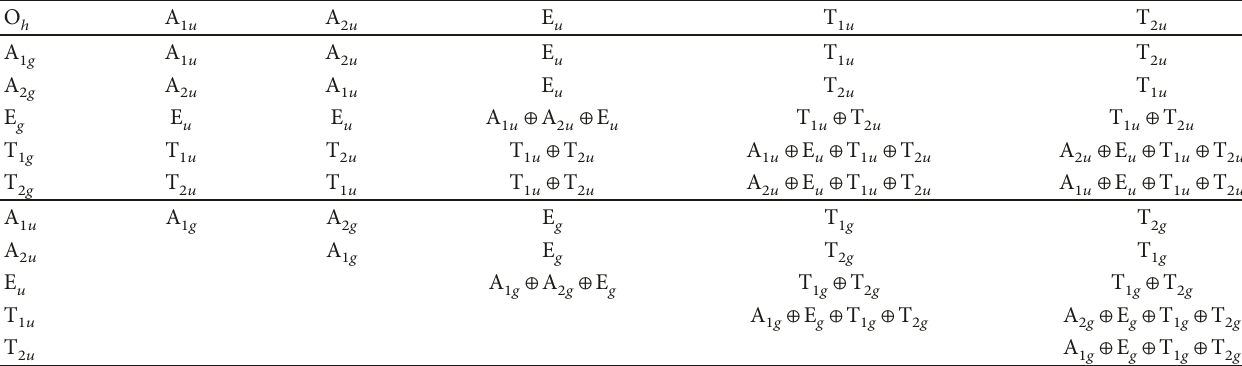
symmetry (dipole). h